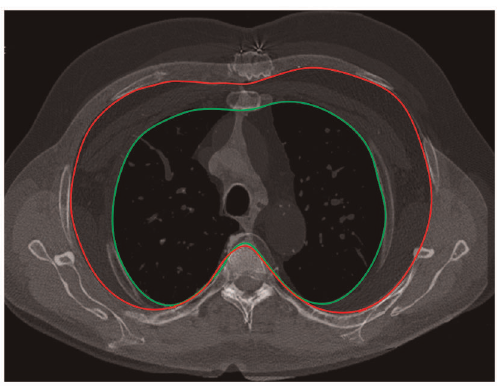
Figure 2. Example showing the independent effect of emphy- sema. Two overlapping upper (second level) CT slices of two different male subjects with similar demographic characteristics: the subject with the smaller area (green line) had an emphysema extent of 2.1%, whereas the one with the larger area (red line) had an emphysema extent of 35%.